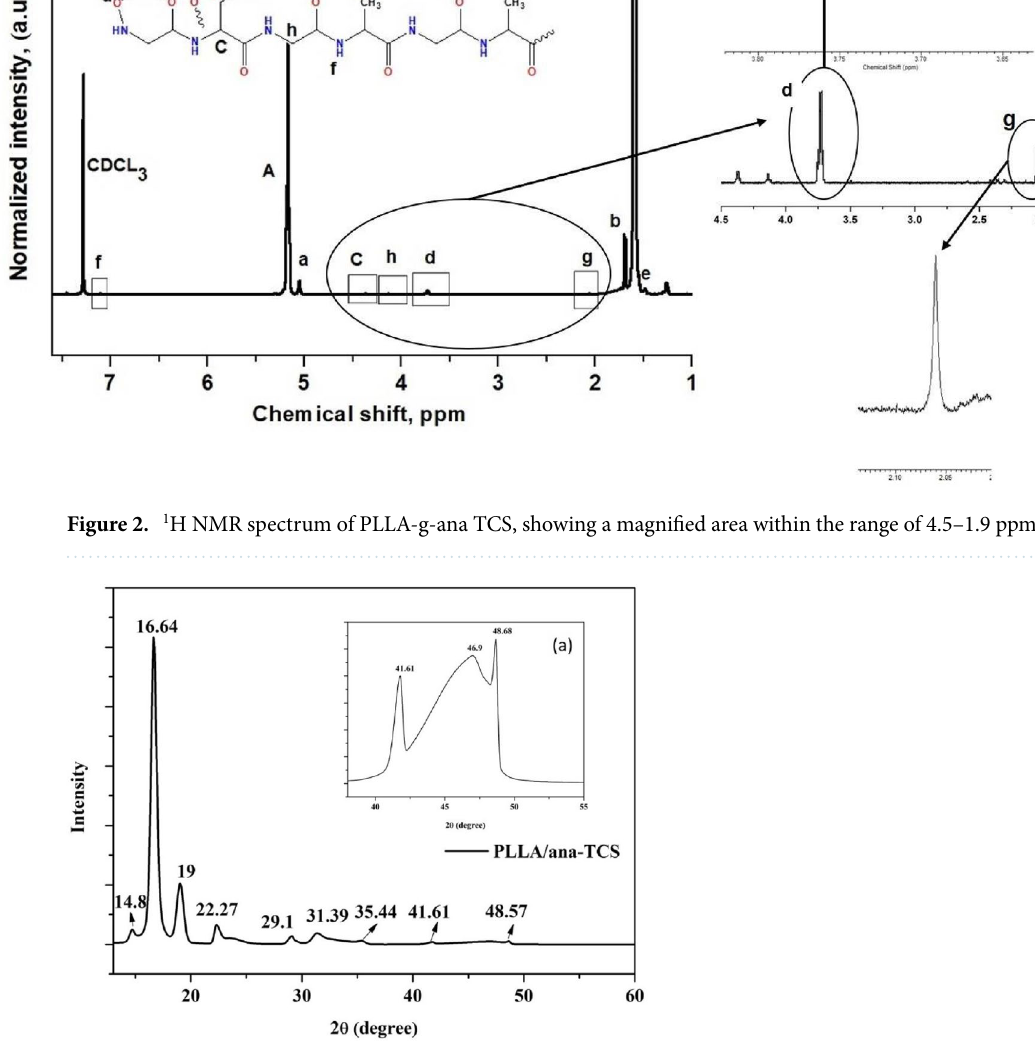
Figure 3. Structural evolution analysis using the XRD spectra of PLLA/ana-TCS, ( a ) inset: the magnified area between the range of 40–50° to show the peak at 48°